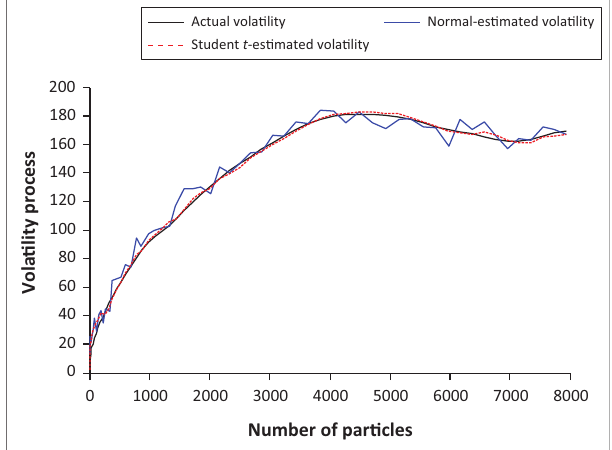
FIGURE 10: Brownian path for Chemical & Allied